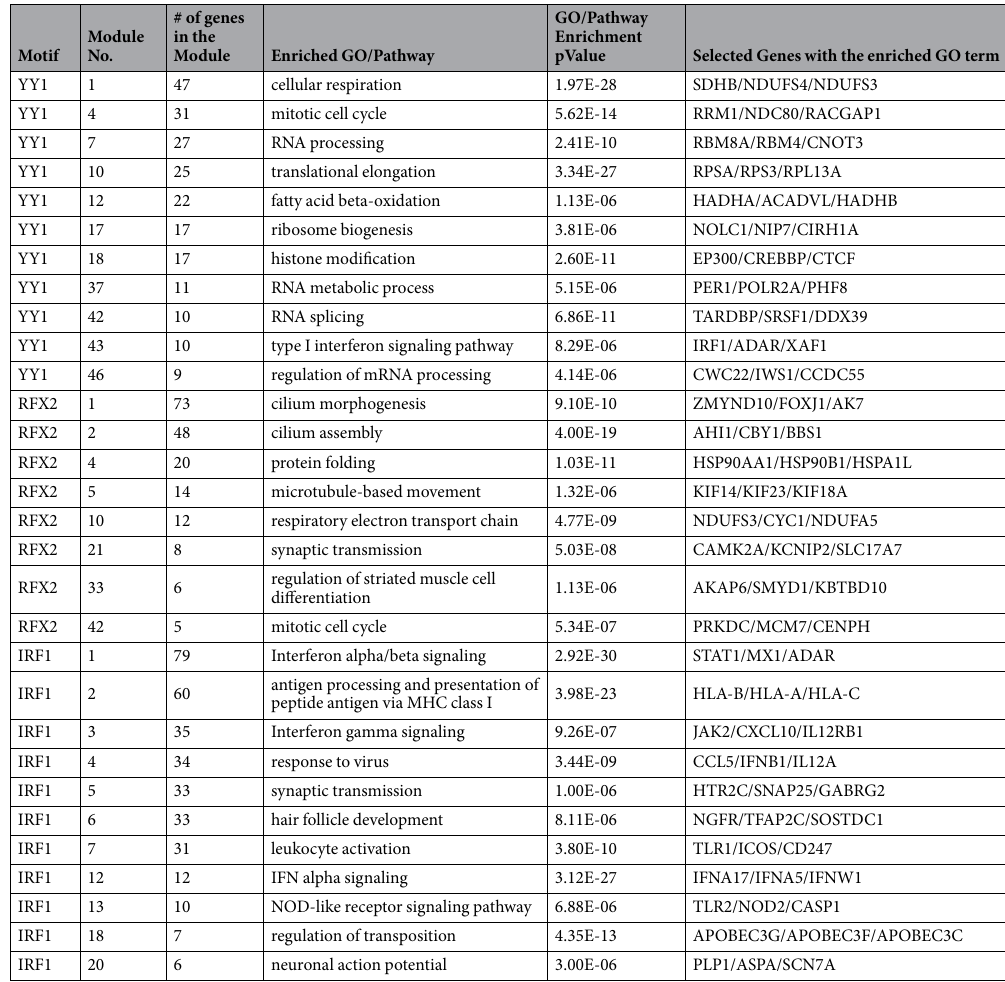
Table 3. Gene modules regulated by YY1, RFX2, and IRF1